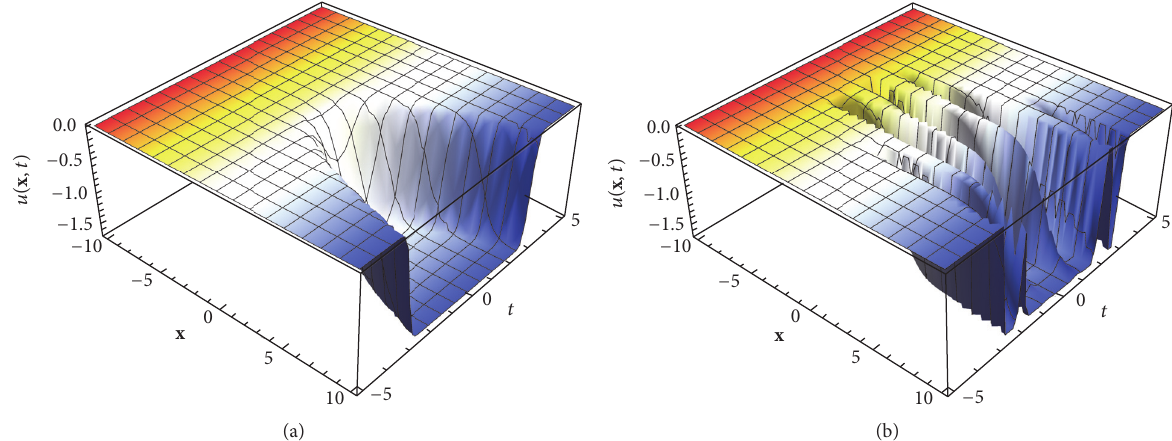
Figure 3: Profiles of the exact solution (37): (a) dark-soliton solution with 𝐵(𝑡) = 0 and (b) dark-solitons solution with 𝐵(𝑡) = 2 sin (5𝑡)